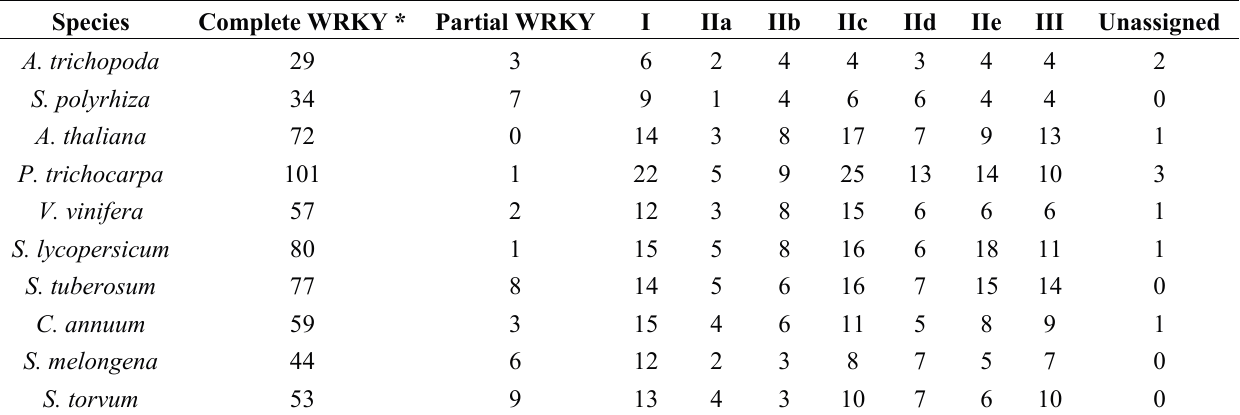
Table 1. The distribution of WRKY TFs from ten plant species. * For Group I, at least one of the two WRKY domains was identified as